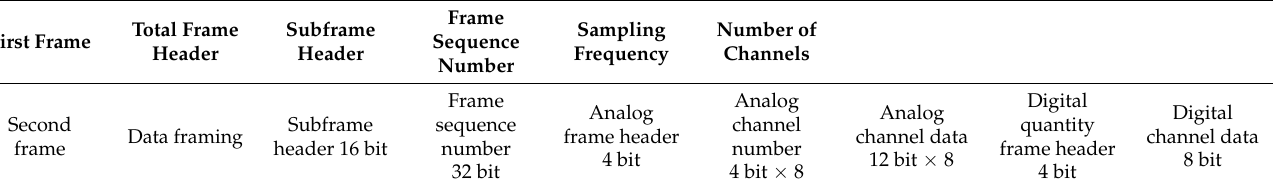
Table 2. Image coding hidden data framing format.